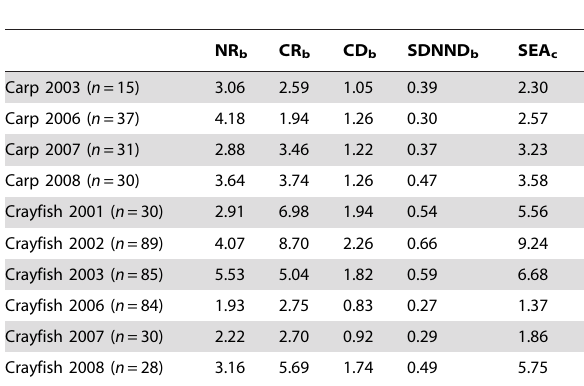
Table 3. Population metrics for carp and crayfish in Lake Naivasha, grouped by year